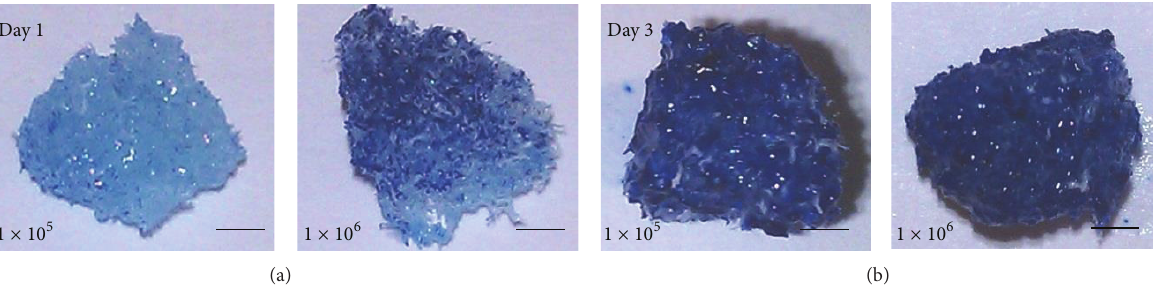
Figure 3: The photo images of scaffold cultures shown above are stained with methylene blue on day 1 (left panel) and day 3 (right panel) the two panels of each day show the scaffold culture seeded with 1 × 10 5 and 1 × 10 6 cells, respectively. Scale bars are 1mm.